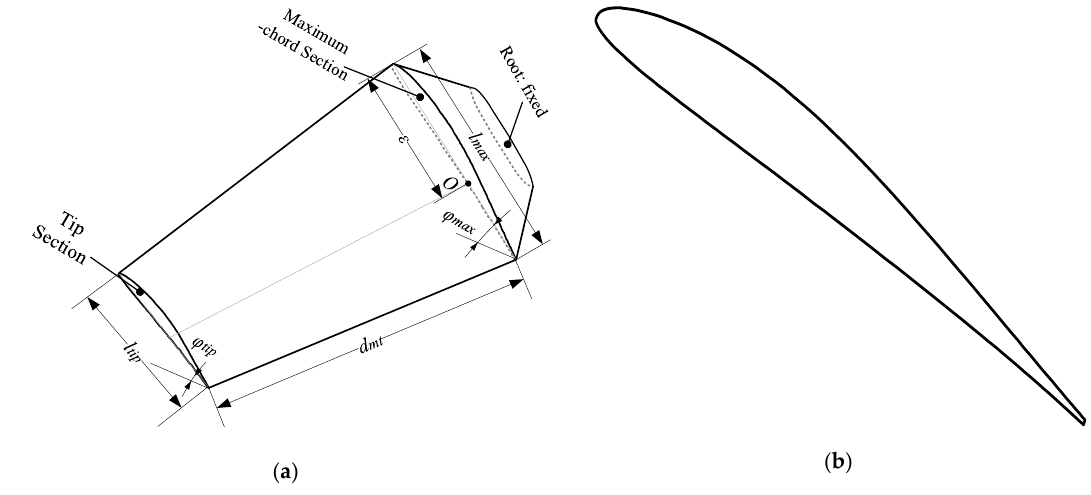
Figure 7. Rotor blade. ( a ) rotor blade and structural variables; ( b ) airfoil of rotor blade. Table 10. Variables of rotor blade.